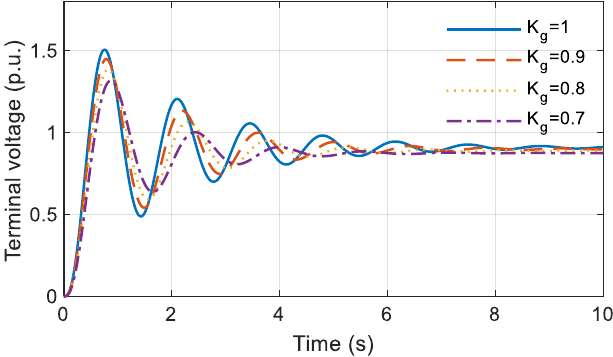
Figure 2. Step response of the AVR system without the controller.